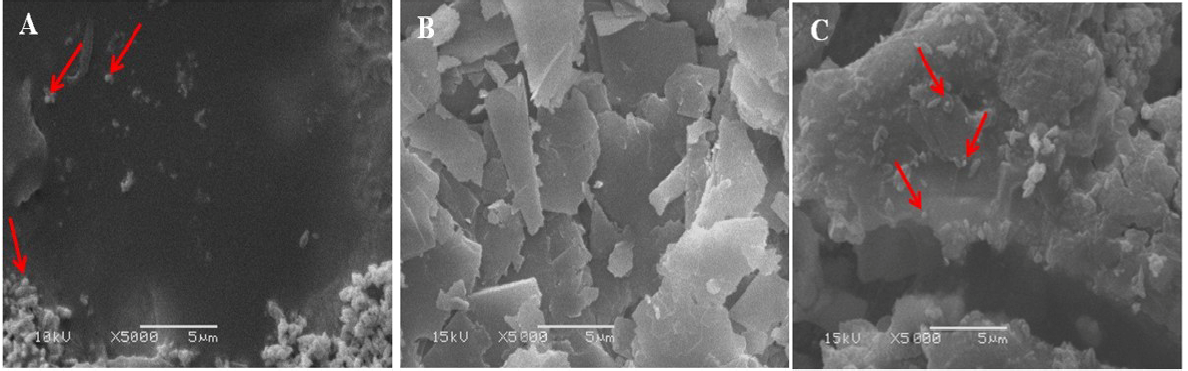
Figure 4. Scanning electron micrographs of talc-based formulations of Streptomyces cellulosae Actino 48 ( A ) culture, ( B ) supernatant, and ( C ) pellet formulations. Arrows indicate the presence of S. cellulosae Actino 48 spores in bioformulations.